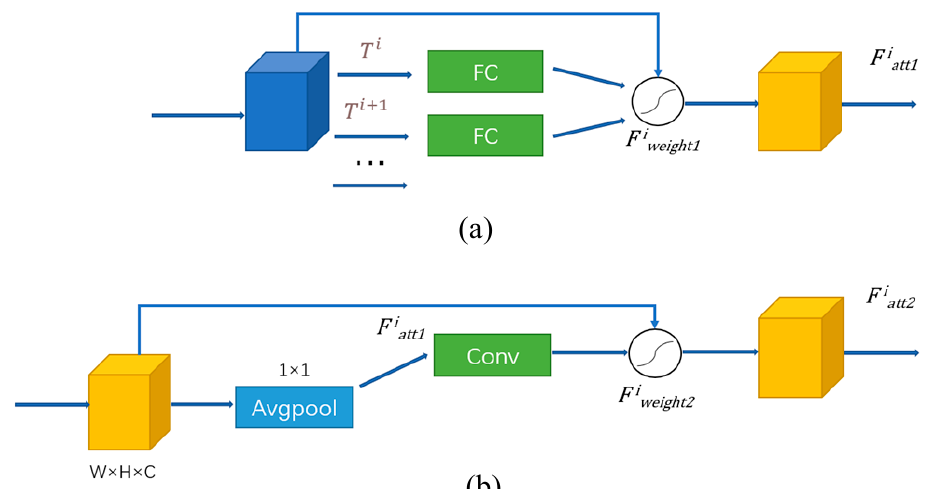
Figure 2. Hybrid attention module structure: ( a ) self-attention module; ( b ) spatial attention mod- ule.